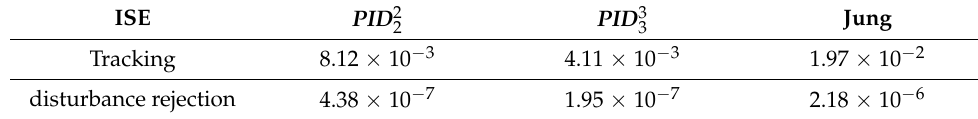
Table 8. The ISE values for all three controllers in tracking and disturbance